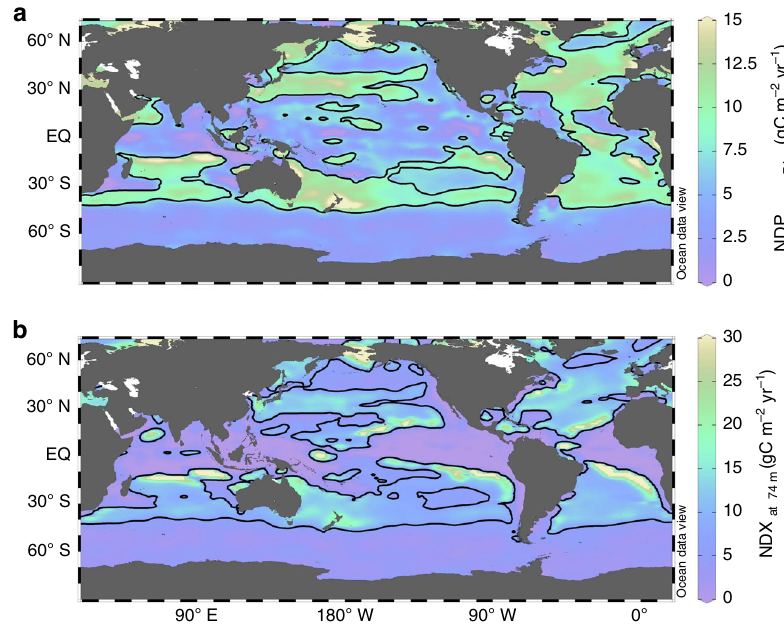
Fig. 2 Maps of net DOC production and export fl uxes. Net DOC production (NDP) in the upper 74 m ( a ) and net DOC export (NDX) below 74 m ( b ). At steady state, the global summation of NDX is equal to that of NDP, and is 2.31 ± 0.60 PgC yr −